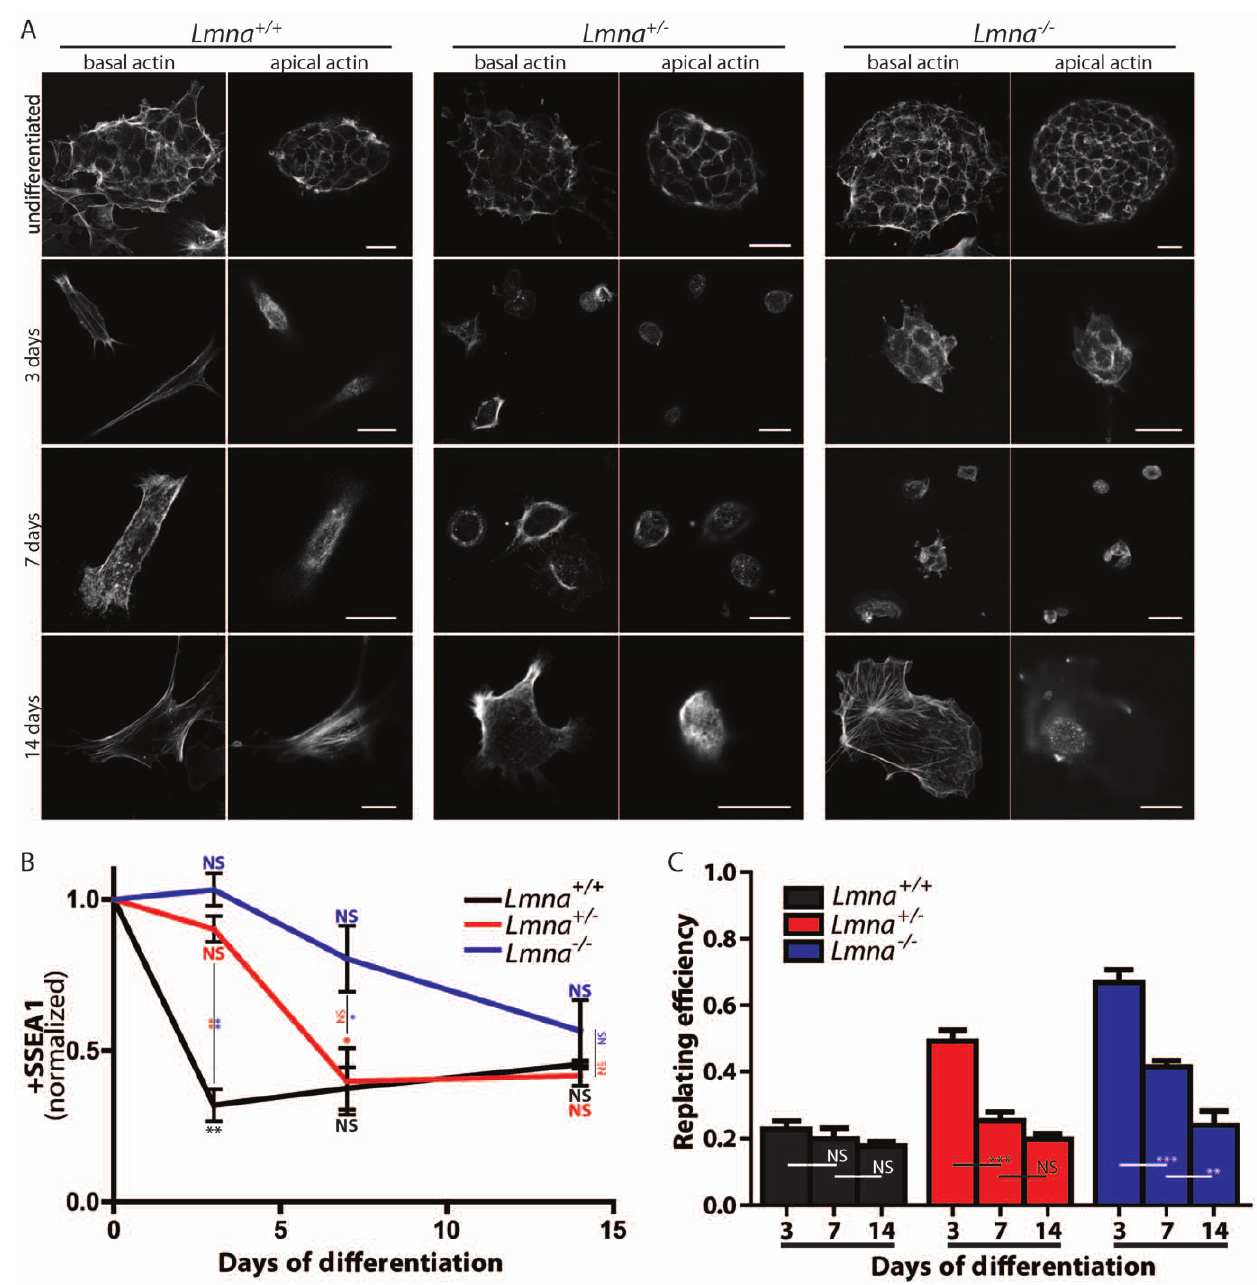
Figure 7. Lamin A/C is required for the proper differentiation of mouse embryonic stem cells (mESCs). A. Representative micrographs of basal (left columns) and apical (right columns) actin of Lmna + / + , Lmna + / 2 , and Lmna 2 / 2 mouse embryonic stem cells at day 0 (top row), at 3 days of differentiation (middle row), and after 14 days of differentiation (bottom row), illustrating the earlier appearance of the actin cap in wildtype cells (by 3 days) when compared to heterozygotes ( , 7 days) and knockouts ( . 14 days). All scale bars: 20 m m. B. Flow cytometry analysis of normalized stage- specific embryonic antigen 1 (SSEA1) levels of Lmna + / + , Lmna + / 2 , and Lmna 2 / 2 mESCs through 14 days of differentiation. C. Replating efficiencies of Lmna + / + , Lmna + / 2 , and Lmna 2 / 2 mESCs after 3, 7, and 14 days of differentiation. *: P , 0.05; **: P , 0.01. ***: P , 0.001; ns: non-significant